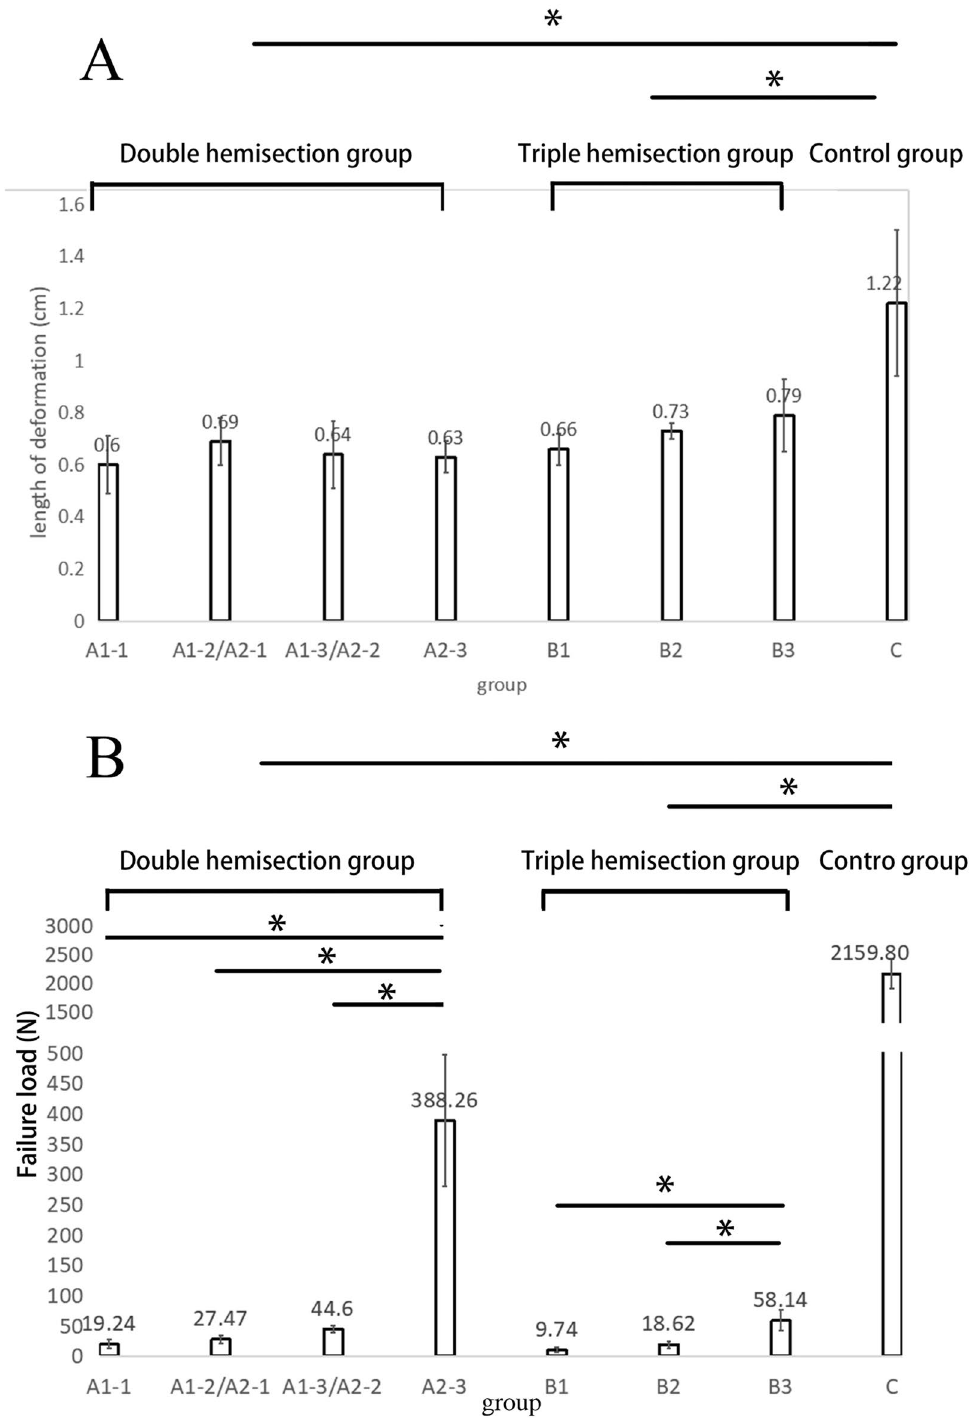
Figure 6. ( A ) Length of the deformation of tendons and ( B ) failure load with different treatments. ( A ) The length of the deformations of intact tendons (Group C) was significantly higher than tendons in the double- and triple-hemisection groups (Groups A and B). ( B ) *P < 0.05. Failure load of tendons in A2-3 were significantly higher than other sub-groups of the double-hemisection group. The failure load of tendons in B3 was significantly higher than that of tendons in B1 and B2 in the triple-hemisection group. The failure load of tendons in Group C was significantly higher than that of tendons in Groups A and